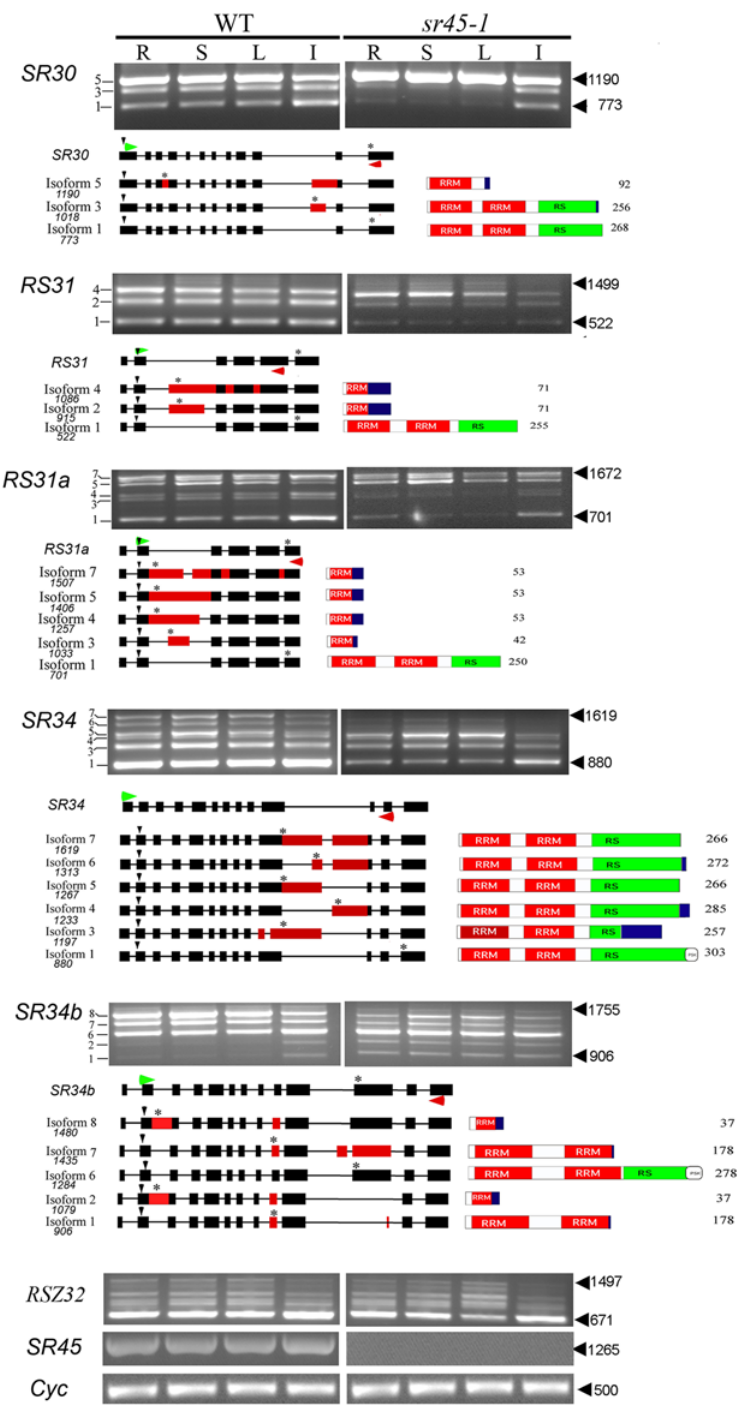
Figure 3. Expression and alternative splicing of pre-mRNAs of ArabidopsisSRgenes in different organs is altered in thesr45-1plants. Expression levels were analyzed by RT-PCR with primers specific to each SR gene. Sequences of forward and reverse primers used are shown in Table S3. An equal amount of template in each reaction was verified by amplifying a constitutively expressed cyclophilin. The name of the SR gene is shown on the left of each panel. DNA sizes are indicated on the right. Isoform number is indicated on the left side of the gel. R, root; S, stem; L, leaf and I, inflorescence. Schematic diagrams in the bottom panel for each gene show the gene structure and its alternatively spliced mRNA isoforms (Numbers below each isoform indicate the number of nucleotides). Predicted proteins from splice variants are shown to the right of each isoform. Exons are filled rectangles and introns are thin lines. Black rectangles represent constitutively spliced exons whereas the red rectangles indicate the included regions in splice variants. Vertical arrowhead and ‘*’ show start and stop codons, respectively; Horizontal green and red arrowheads above and below gene structures indicate the position of forward and reverse primers, respectively. In the schematics of predicted proteins, numbers to the right are the number of amino acids in the protein. RRM, RNA recognition motif, RS, Arginine/Serine-rich domain. Blue rectangle indicates a stretch of amino acids that are not present in functional SR proteins.